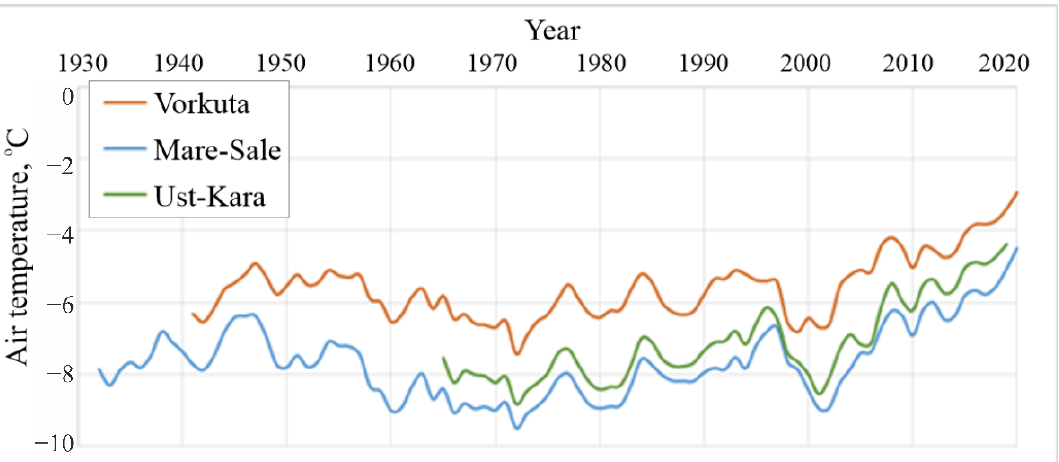
Figure 3. Annual mean air temperature (5-year averaging) at three meteorological stations: Vorkuta, Mare-Sale, and Ust-Kara (see Figure 1 for their locations).